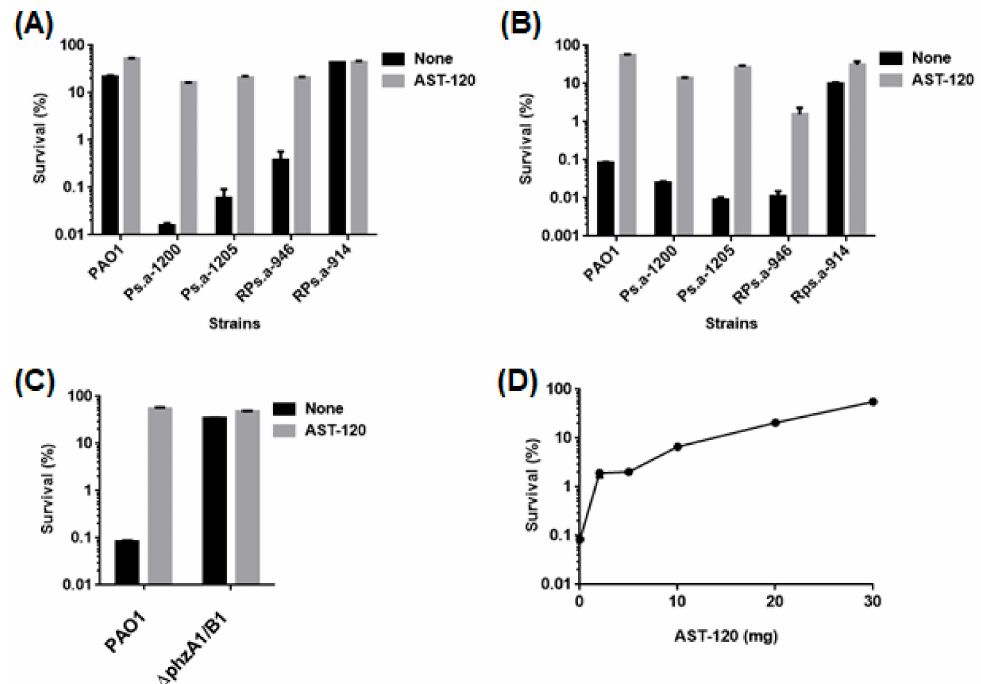
Figure 4. Cytotoxicity of supernatants from PAO1 parent and its phzA1/B1 mutant strains and drug-resistant clinical isolates. ( A ) Survival of A-549 cells after incubation with or without culture supernatants from indicated P. aeruginosa strains cultured in the presence or absence of 30 mg AST-120. ( B ) Survival of Caco-2 cells after incubation with or without culture supernatants from indicated P. aeruginosa strains cultured in the presence or absence of 30 mg AST-120. ( C ) Survival of Caco-2 cells after incubation with or without culture supernatants from PAO1 and its phzA1/B1 mutant ( ∆ phzA1/B1), the phenazines non-producer, cultured in the presence or absence of 30 mg AST-120. ( D ) Survival of Caco-2 cells after incubation with or without culture supernatants from PAO1 cultured in indicated amounts of AST-120. The survival rates are presented as the percentage of the RLU value for the cells after incubation with each supernatant relative to that after incubation without supernatant. Data plotted are the means of two biological replicates, error bars indicate the ranges. We repeated experiments twice, then obtained similar